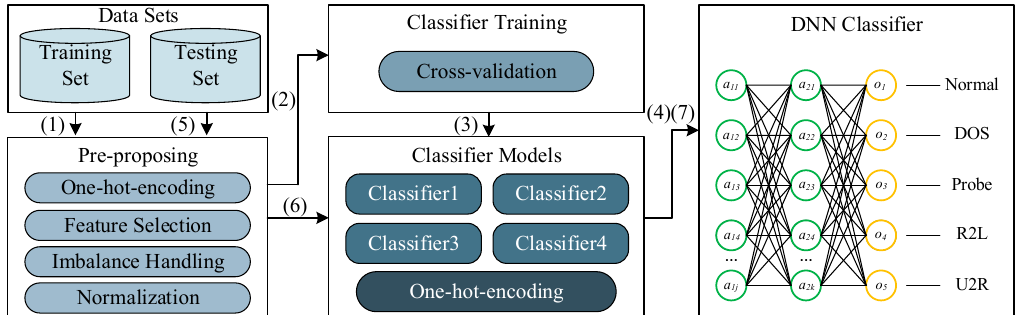
Figure 2. Deep stacking network model.